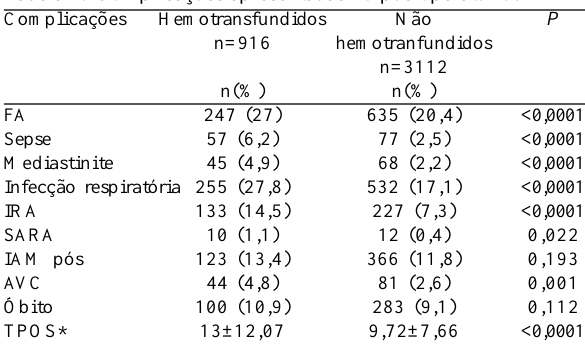
Tabela 2. Complicações apresentadas no